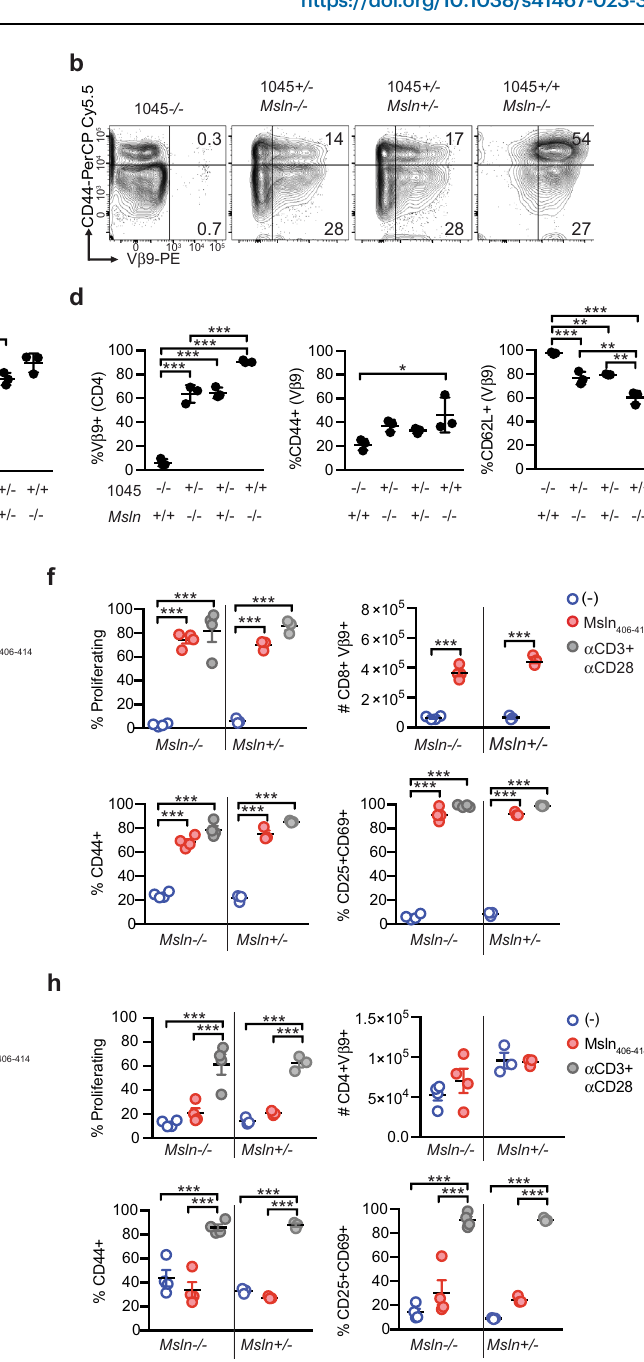
Fig. 5 | Peripheral 1045 T cells from Msln − / − or Msln +/ − mice respond to speci fi c antigen. a Representative plots gated on splenic CD8 T cells. b Representative plots gated on splenic CD4 T cells isolated from the indicated mouse strains. c Frequency of splenic CD8 T cells that express V β 9 (left) and frequency of CD8+V β 9+ T cells that express CD44 (middle) or CD62L (right). Data are mean± SEM. n =3 biologically independent animals. * p <0.05, ** p <0.005, *** p <0.0005. One-way ANOVA with a Tukey ’ s posttest. d Frequency of splenic CD4 T cells that express V β 9 (left) and frequency of CD4+V β 9+ T cells that express CD44 (middle) or CD62L (right). Data are mean±SEM. n =3 biologically independent animals.